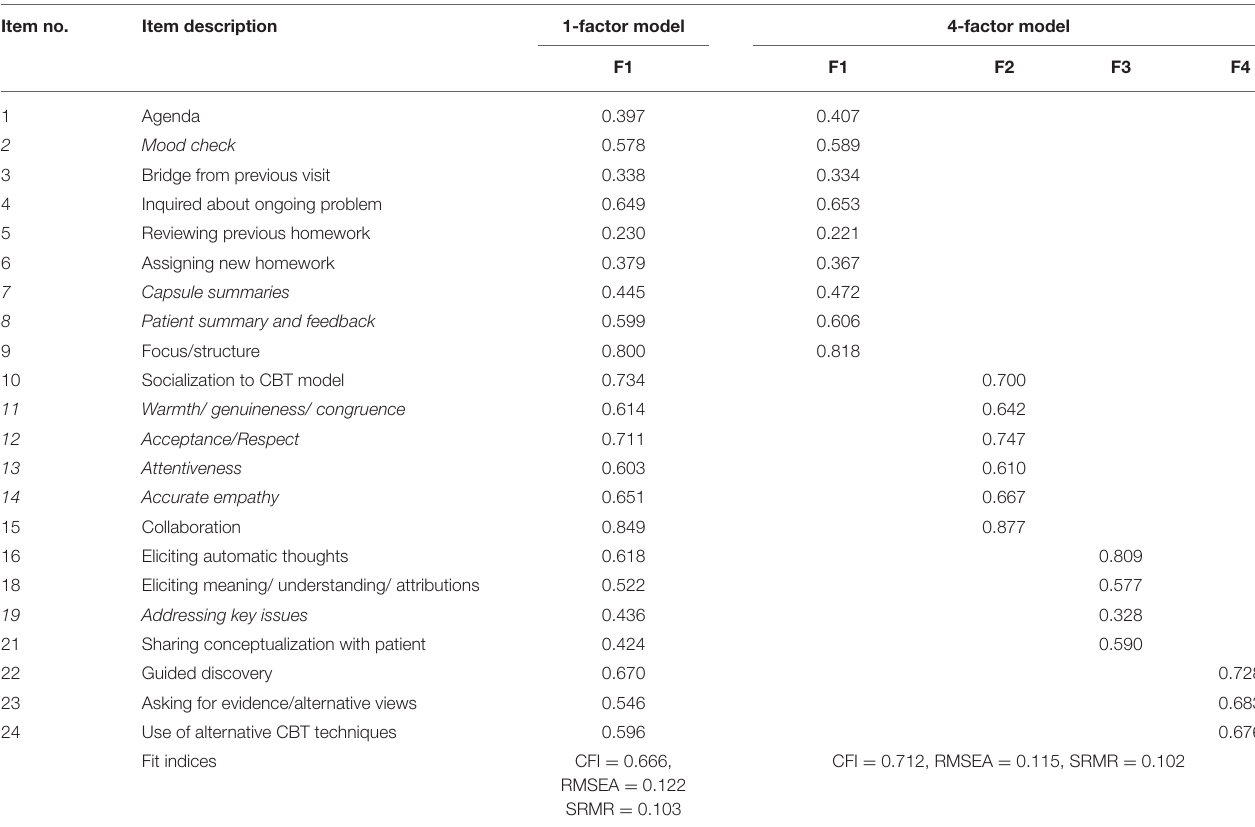
TABLE 2 | CFA for CTACS based on one-factor and a four-factor solutions, standardized ( n = 333). Item